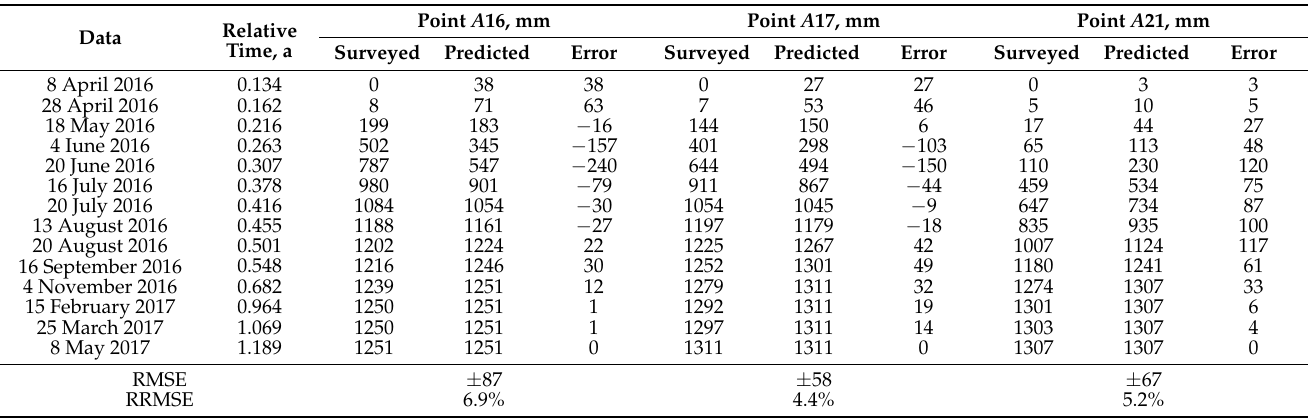
Table 4. Comparison of the predicted results with the measured